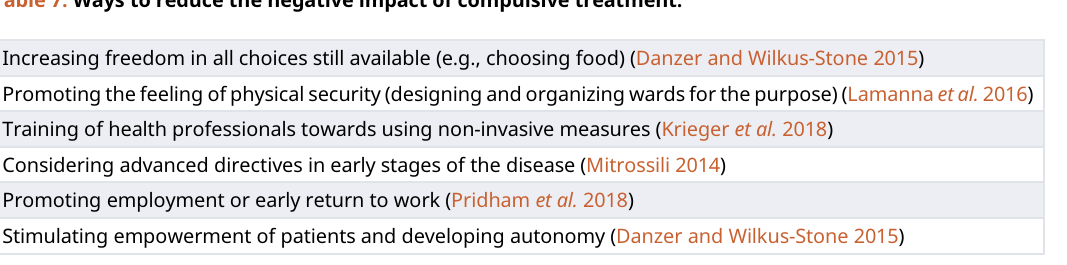
Table 7. Ways to reduce the negative impact of compulsive